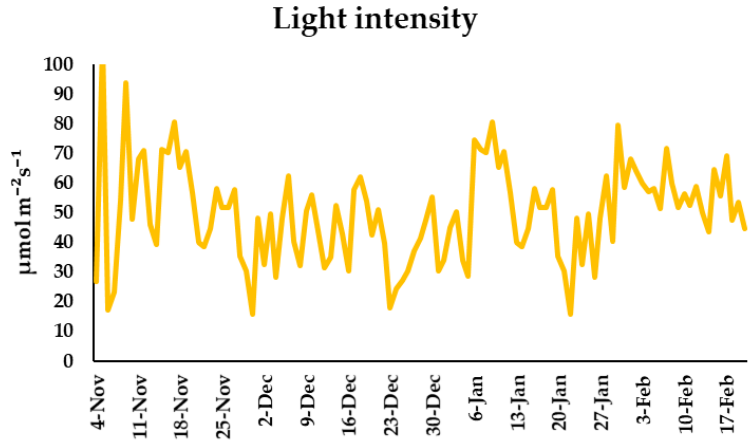
− 2 s − 1 ) during the